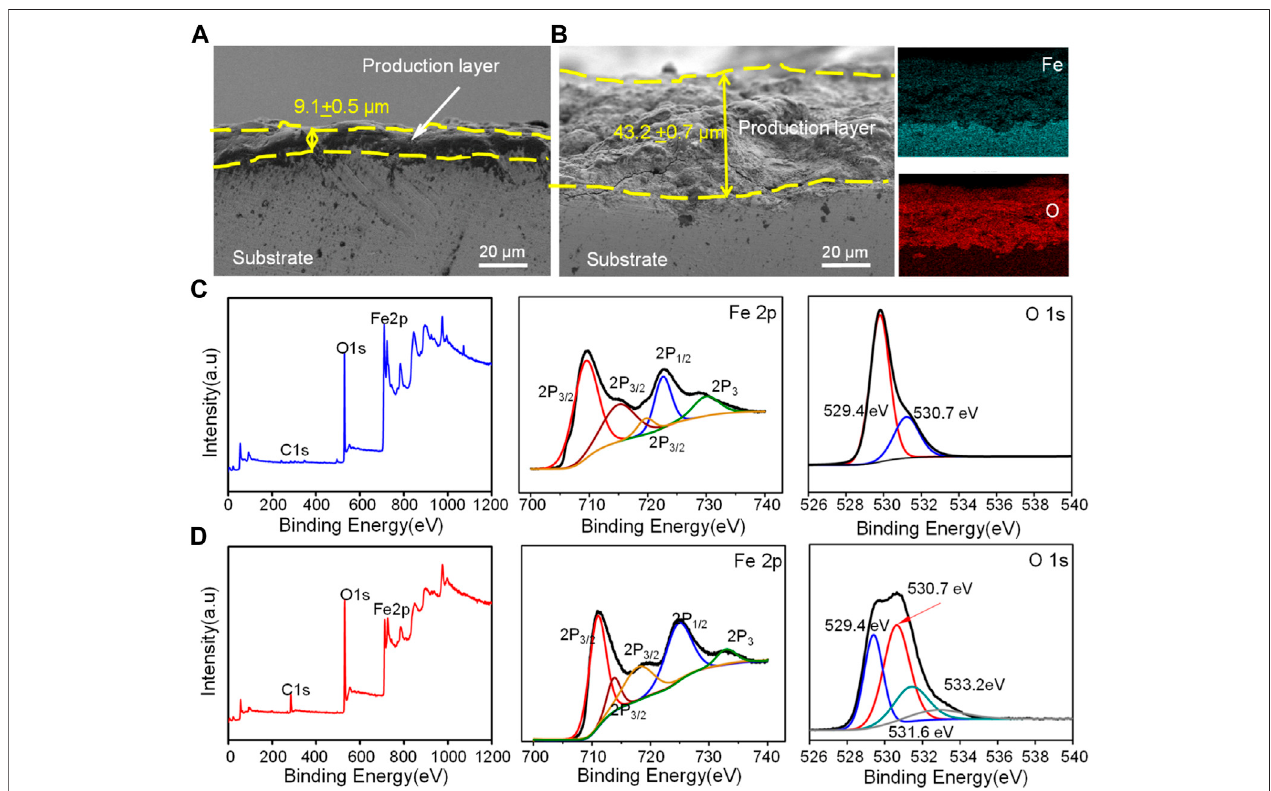
FIGURE 4 | The cross section of corrosion production for (A) Fe and (B) Fe/CaCl 2 after immersing for 28 days observed by SEM, and XPS analysis of the oxide layer for (C) Fe and (D) Fe/CaCl 2 , wherein the sputtering time was 10 s.